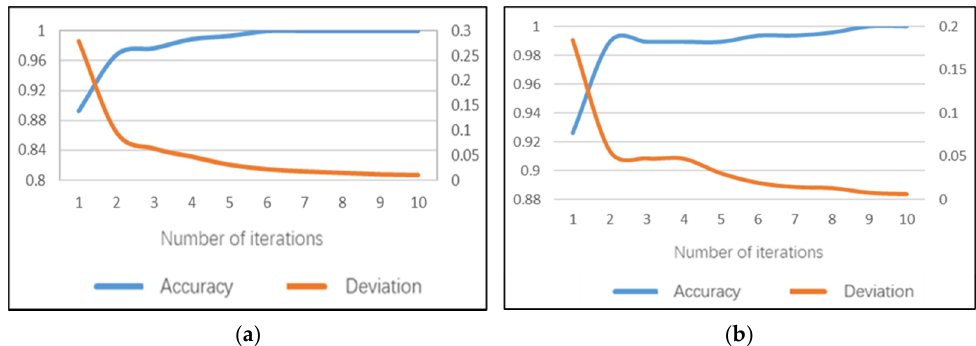
Figure 13. Training performance of phone calling sub-model: ( a ) daytime; ( b ) night.